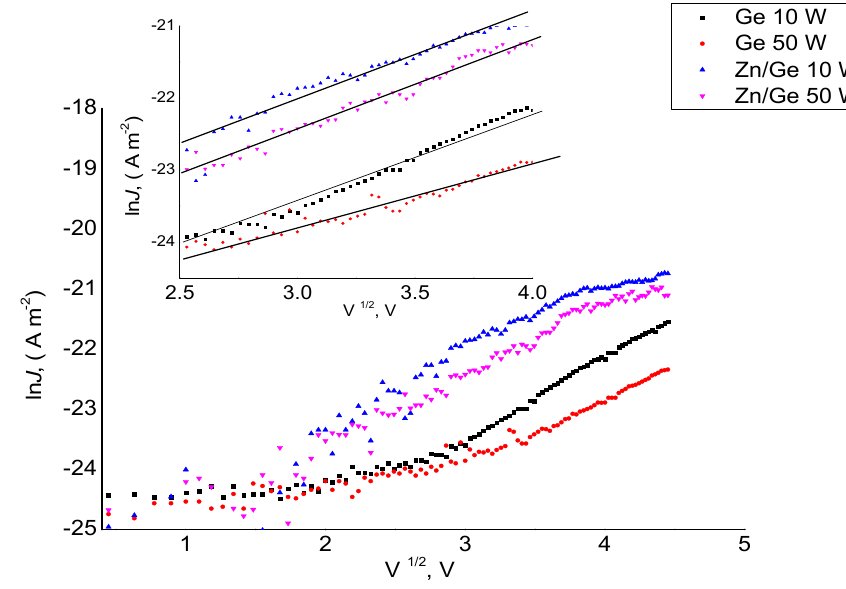
Figure 5. Density ln J with the square root of applied voltage for pristine and composite polymer films manufactured at 10 W and 50 W.